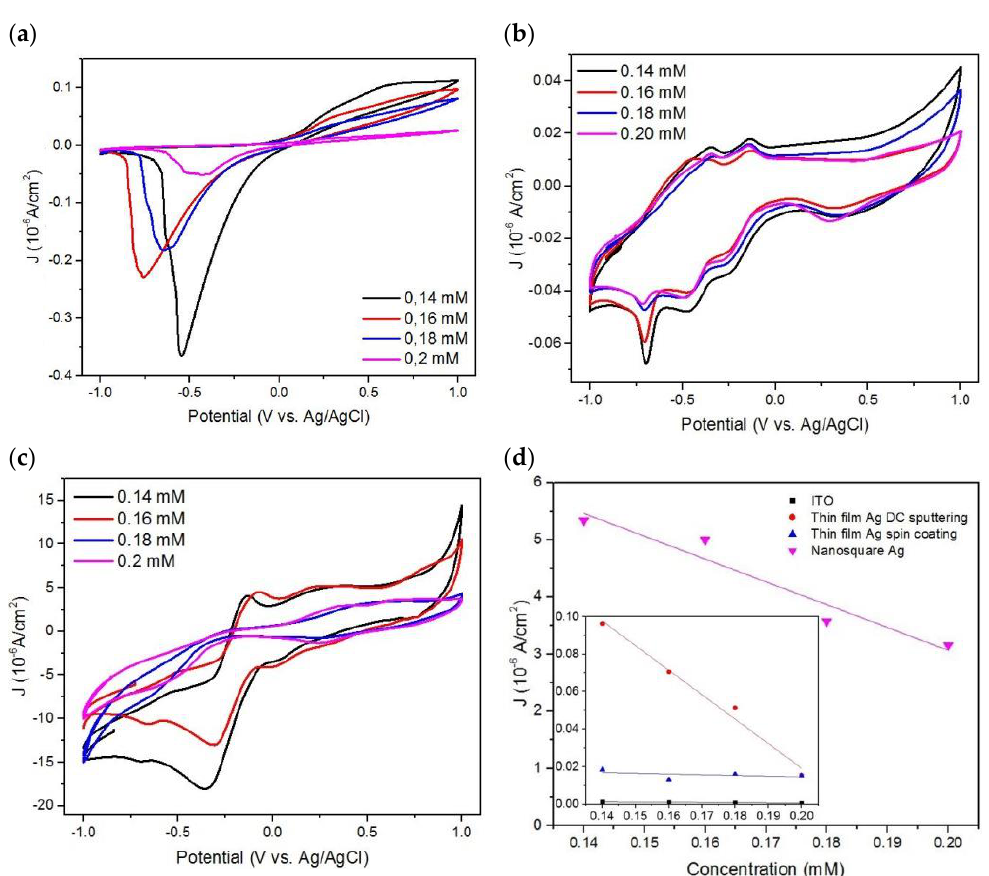
Figure 7. The experiment results of the CV measurement using various concentrations of PBS+BSA as a function of BSA concentration on ( a ) Ag thin-film electrode deposited using DC sputtering, ( b ) Ag thin-film electrode deposited using spin coating, and ( c ) Ag nanosquare array. ( d ) Response of the current towards the change in concentration of the medium.